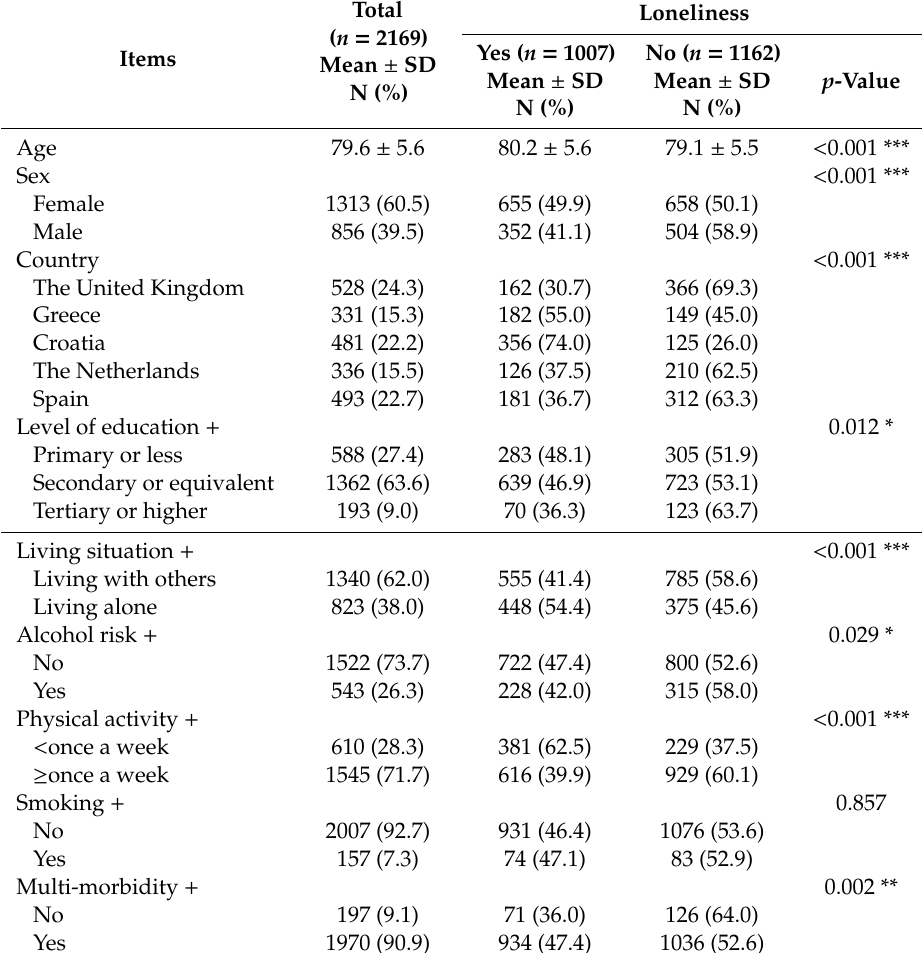
Table 1. General characteristics of the study population.